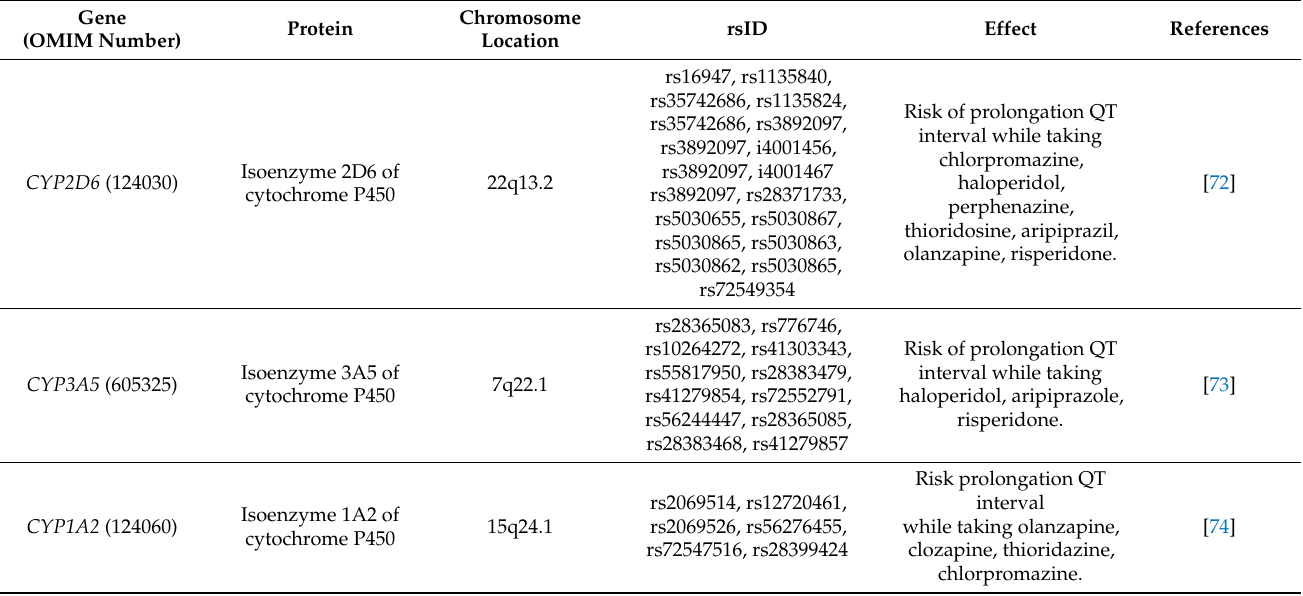
Table 4. Candidate genes and their single nucleotide variants responsible for altering the pharma- cokinetics of antipsychotics and leading to secondary antipsychotic-induced cardiac arrhythmias and conduction disorders.